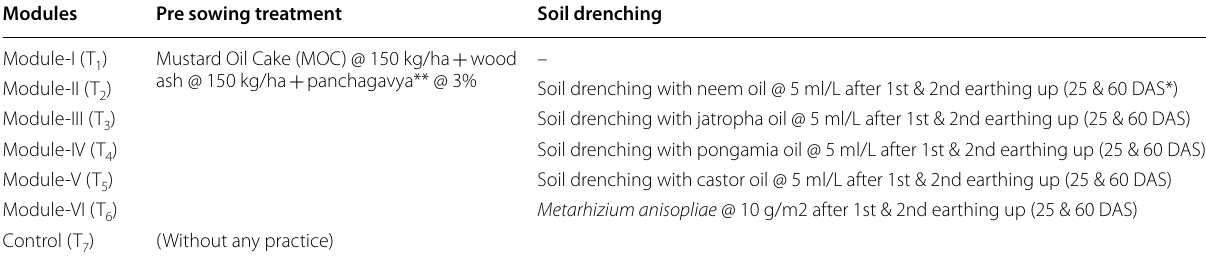
DAS*-Days after Sowing Panchagavya**: Panchagavya is an organic biopesticide formulation consisting of nine products viz. cow dung, cow urine, milk, curd, jaggery, ghee, banana, tender coconut, and water